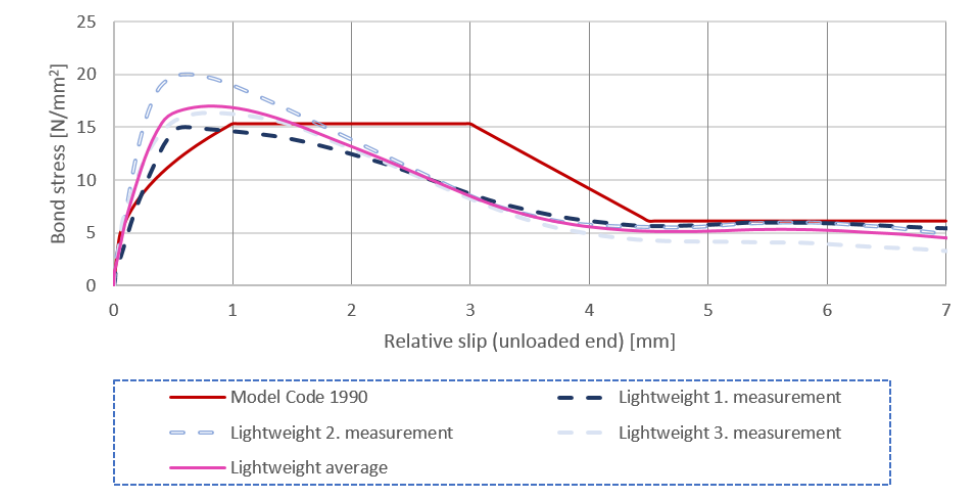
Figure 7. Bond stress–slip curves based on our measurements and the Model Code